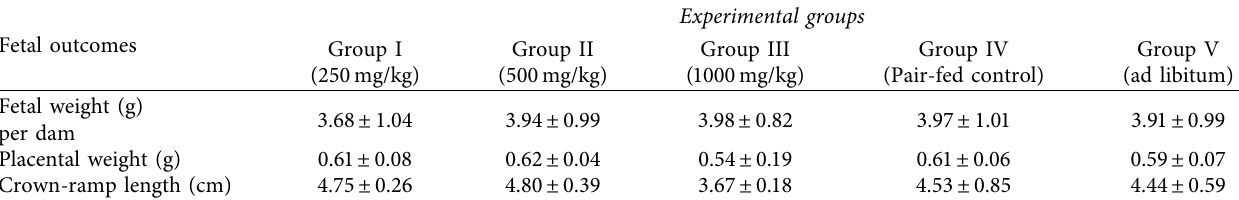
Table 7: Fetal outcome of rats treated with 80% ethanol fruit extract of Embelia schimperi . Fetal